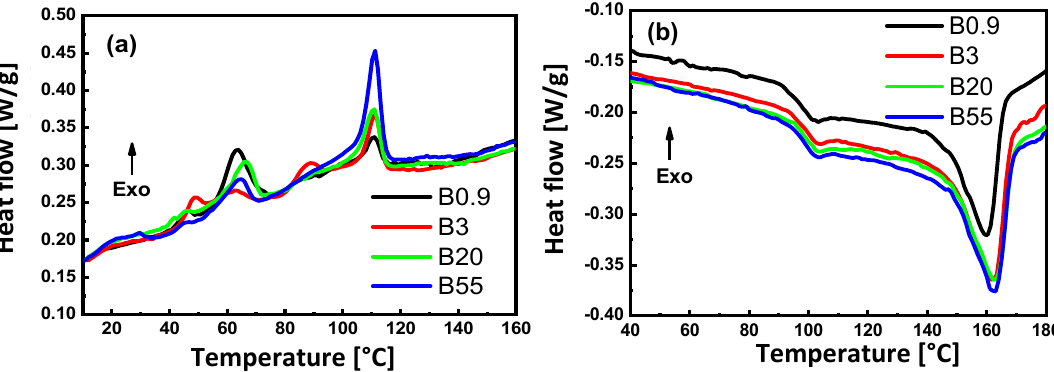
Figure 4. Thermal characterization of composites (B0.9, B3, B20, and B55) prepared with di ff erent